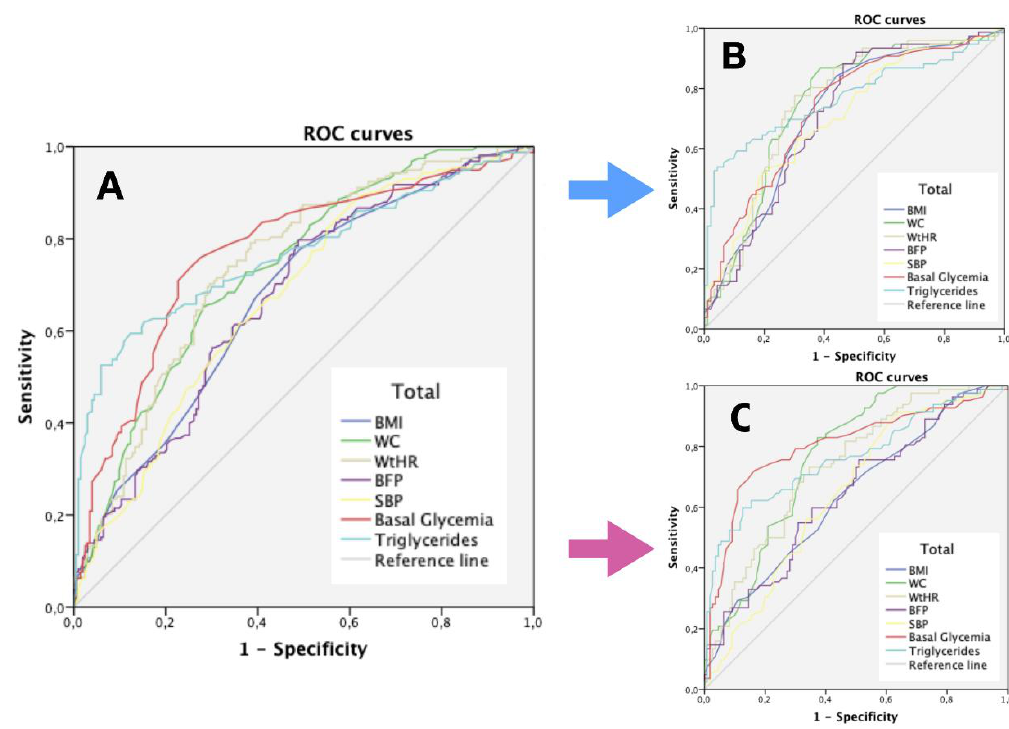
Figure 1. ROC curves for anthropometric and analytical variables predictive of MetS in the elderly ( n = 158). ( A ) ROC curves of anthropometric and analytical variables predictive of MetS in the total sample ( n = 361); ( B ) ROC curves of the most essential anthropometric and analytical variables of MetS in older men ( n = 169); ( C ) ROC curves of the most essential anthropometric and analytical variables of MetS in older women ( n = 198). ROC: receiver operator characteristic; BMI: body mass index; WC: waist circumference; WtHR: waist height ratio; BFP: body fat percentage; SBP: systolic blood pressure.